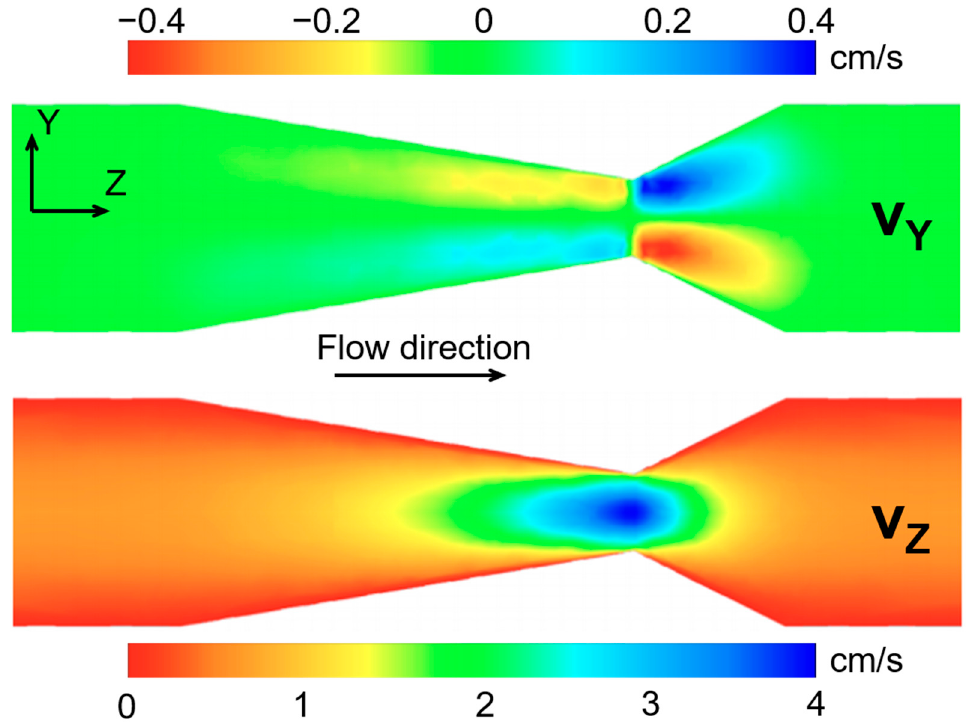
Figure 2. Simulation results of foam flow through the pipe constriction using a Herschel–Bulkley fluid viscosity model, a foam quality of 0.75, and a flow rate of 0.0009 L/s. The bulk flow direction is from left to right. The figure on top shows the results for the Y-component of velocity, and the figure on bottom shows the results for the Z-component of velocity.